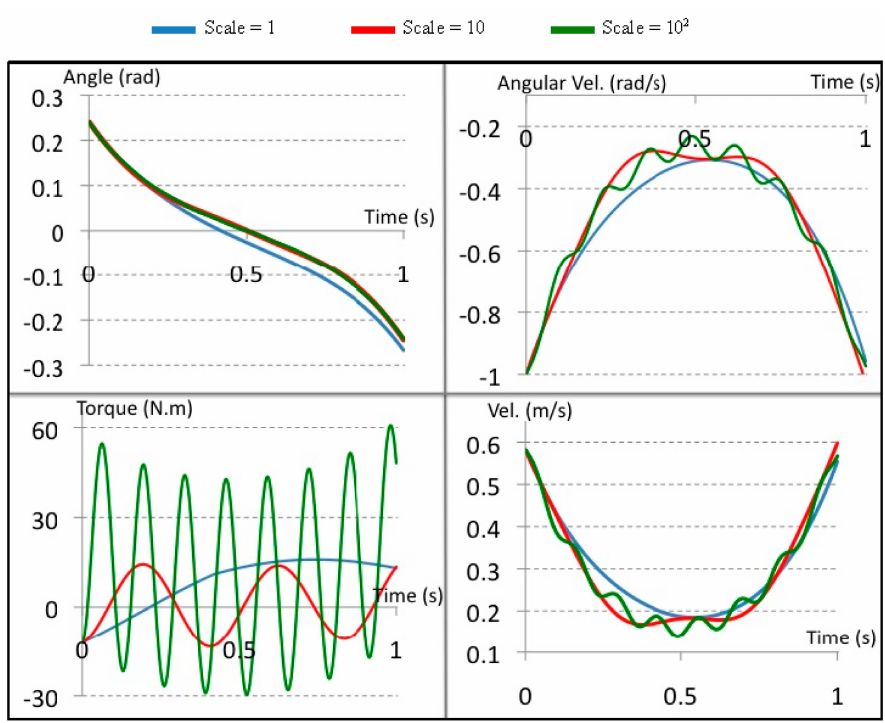
Figure 28. Simulation data for ankle joint during one-step walking in active mode. The data is for 3 experimental tests with different high stiffness scales. Low stiffness spring constant = 80 N/mm. High stiffness spring constant = 400 N/mm. ( a ) ankle pitch joint angle; ( b ) ankle pitch joint angular velocity; ( c ) ankle pitch joint torque; ( d ) CoM forward